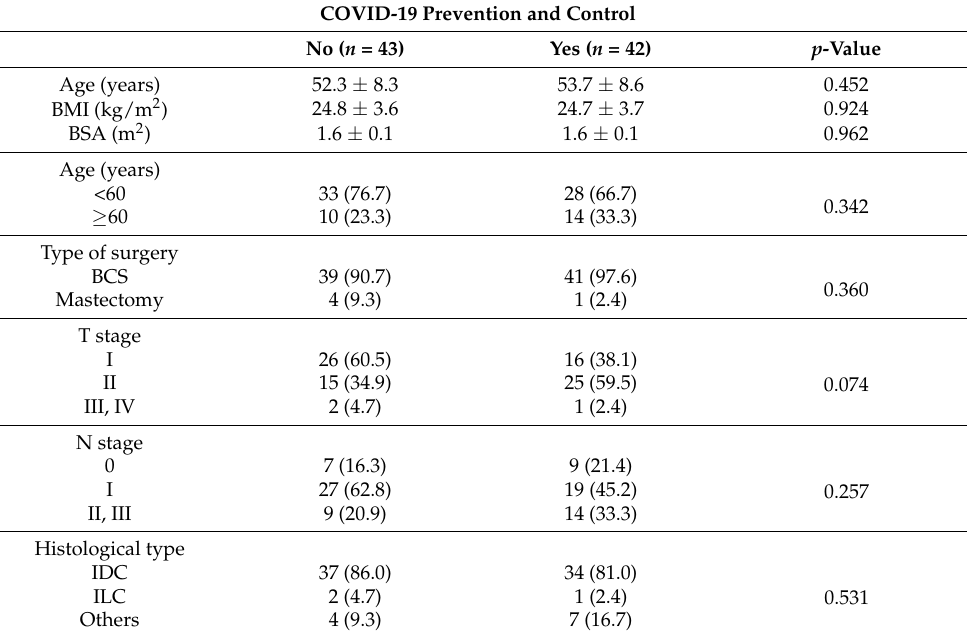
Table 1. Patient demographics and tumor